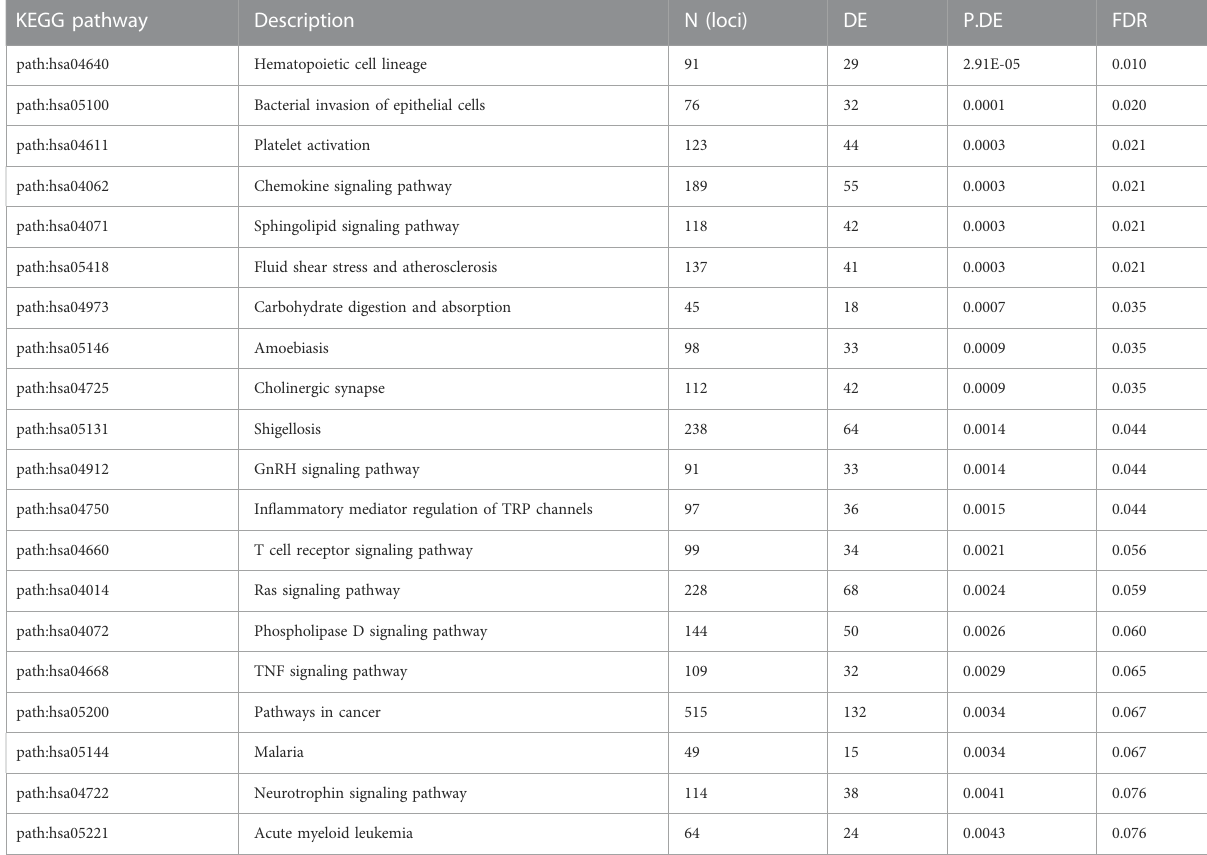
TABLE 2 KEGG pathway analysis of differential methylation in MS at loci not associated with mQTL. KEGG pathway